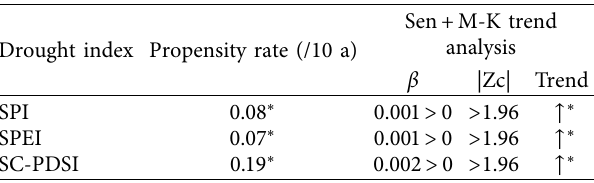
Figure 2: Evolution of the SPI, SPEI, and SC-PDSI in the ARNC during 1950–2012. (a) SPI. (b) SPEI. (c) SC-PDSI. Table 2: Trend analysis and Sen+M-K trend analysis of the SPI, SPEI, and